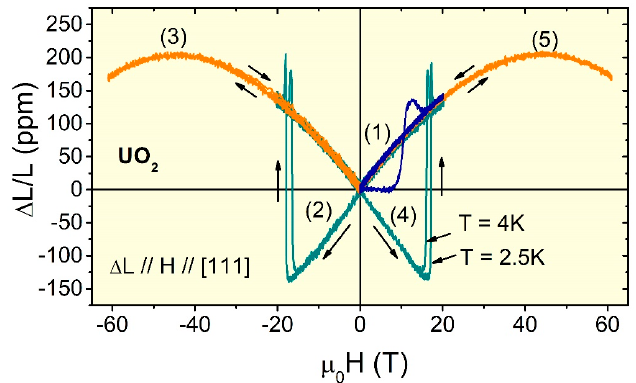
Figure 1. Magnetostriction vs. magnetic field for a single crystalline sample of UO 2 , measured at 2.5 K and 4 K during a 25 millisecond pulsed field exceeding 60 T. The magnetic field was applied along the [111] crystallographic direction in the sequence indicated by numbers (1) through (5). An irreversible transition is observed when the magnetic field is first applied to 20 T (1). Upon reversal of the magnetic field, the magnetostriction changes sign too (piezomagnetism) and the irreversible transition now is much sharper (2). Two consecutive pulses in the same direction superimpose with no irreversibilities (3). The magnetostriction Δ L/L changes sign again when the magnetic field direction is reversed to positive (4) and becomes reversible when a second pulse is applied in the same direction (5). These results first discovered piezomagnetism in UO 2 , a technologically important material and also the strongest piezomagnet known [23]. These data were obtained using the 46 kHz line array InGaAs camera described in Section 2.2 below. The Δ L/L resolution achieved in this experiment is approximately 2 × 10 − 6 .